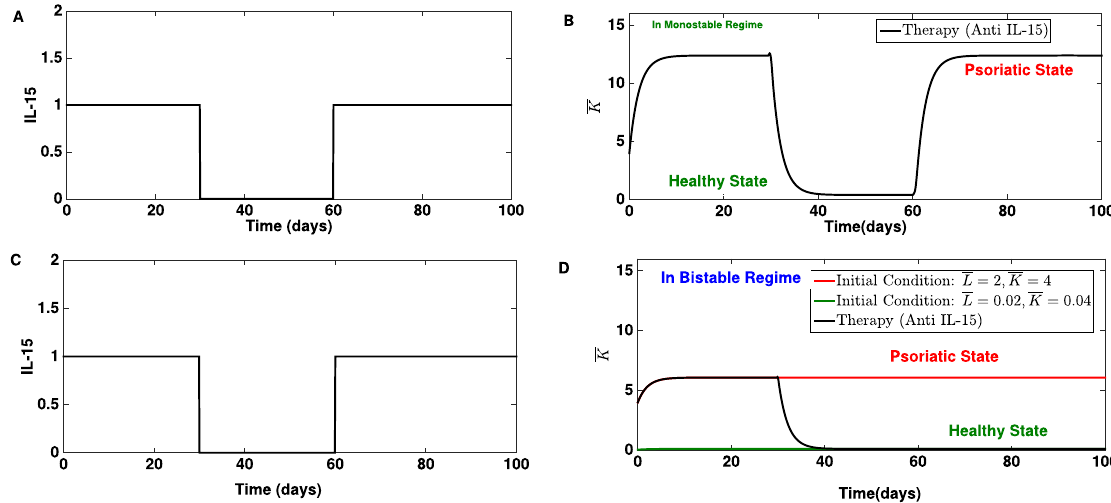
Figure 6. IL-15 signal and treatment of psoriasis using an anti IL-15 drug. ( A , C ) An exemplary IL-15 signal before and after using an anti IL-15 drug. The signal has become an inverse rectangular pulse. The signal vanishes completely between the time interval 30–60 days and bounces back to the initial strength immediately after 60 days. ( B ) The dynamics of the keratinocyte population before and after using an anti IL-15 drug. The disease relapses after the effect of the drug vanishe. The model parameters are: = 6, v = 0.1, r = 0.01, q = 0.2, n = 3, µ L = 0.5 and µ K = 0.5 . The default initial condition is: ¯ K = 4 b ′ IL − 15 and ¯ L = 2 . ( D ) Dynamics of the subnetwork before and after applying the anti IL-15 signal shown in ( A , C ).